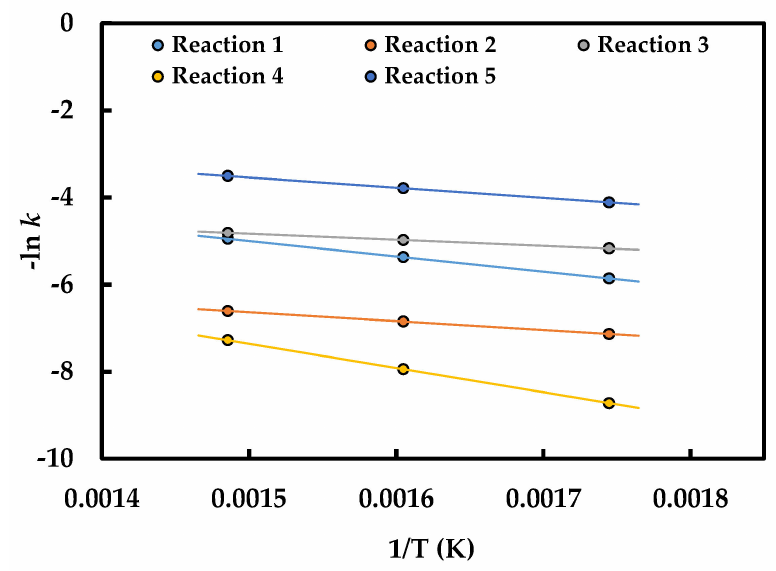
Figure 6. Arrhenius plots for the different reactions.